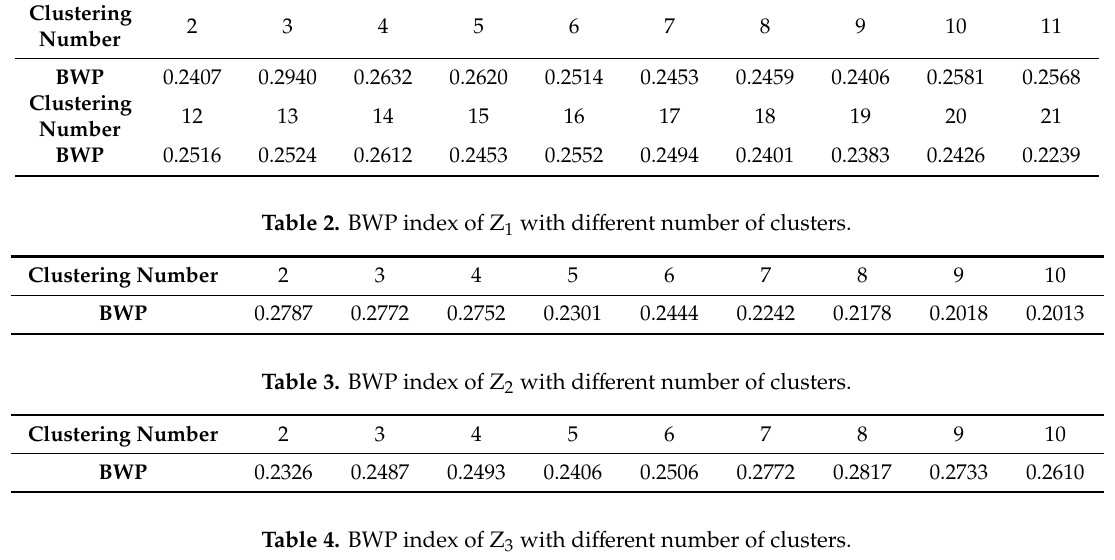
Table 1. BWP index of all reference points with di ff erent number of clusters.